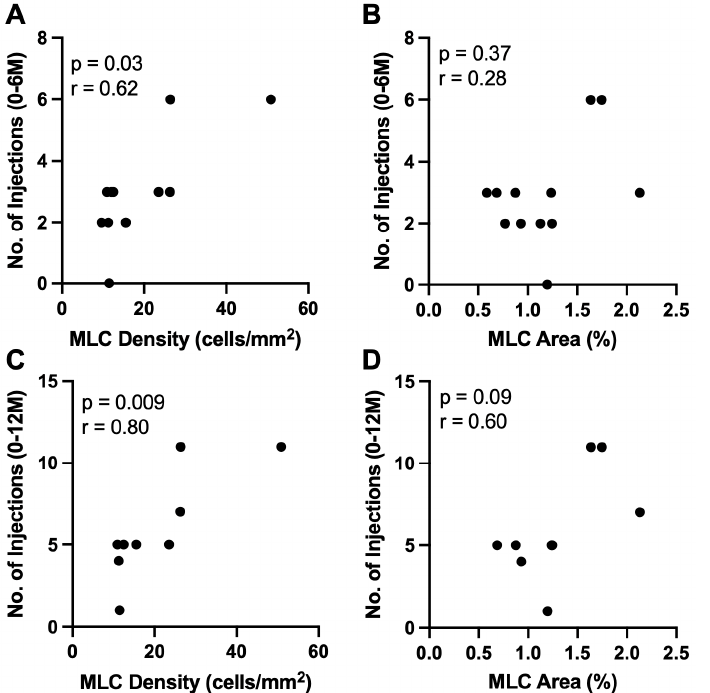
Figure 3. MLC density correlates with number of future intravitreal injections. MLC density ( A , C ) and MLC percent area ( B , D ) correlation with the number of intravitreal injections at 6 months ( A , B ) and 12 months post-imaging ( C , D